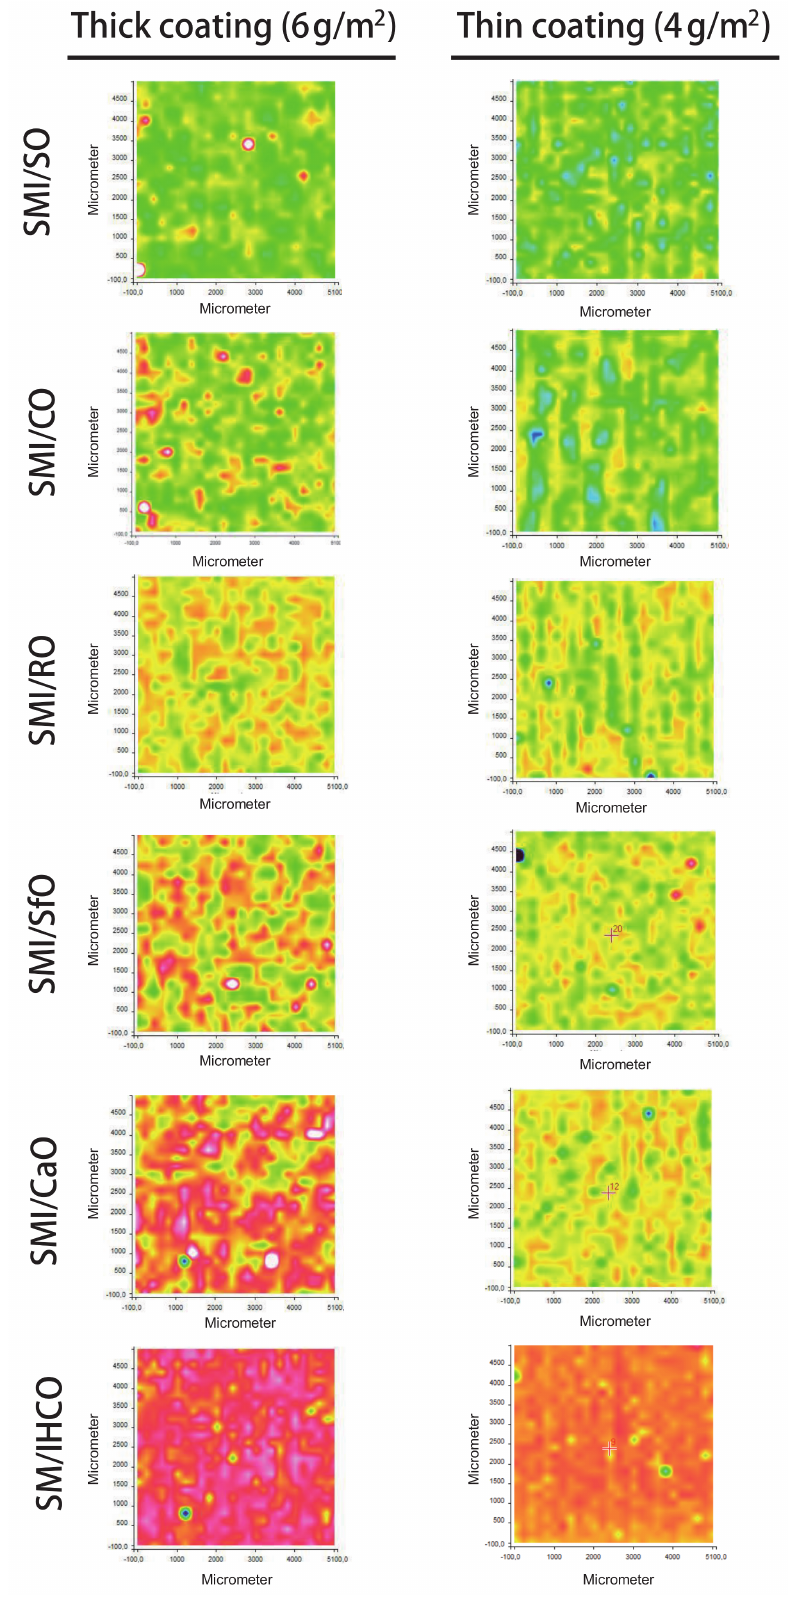
Figure 5. Raman maps (5 × 5 mm 2 ) with average intensities for SMI/oil paper